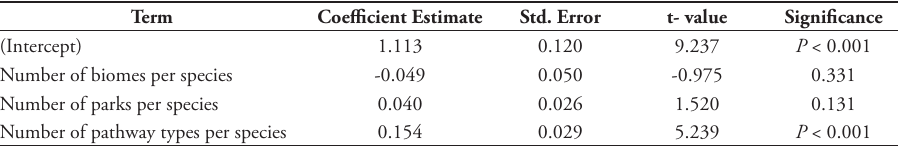
Figure 1. Percentage life forms and total percent species per pathway. Columns show the percent of each life form per pathway type, with the total number of species per pathway above each column. For example, 35% of the species that can be introduced as ornamental plants are trees, and trees make up 45% of the species that can be spread by rivers. Black dots show the total percent of species per pathway type. For example, 78% of the total species can be introduced as ornamental plants, 63% as rivers and 48% by Table 4. The relationship between number of impact types per species and number of biomes invaded, parks invaded and pathways per species. (General linear model with quassi-Poisson link function).